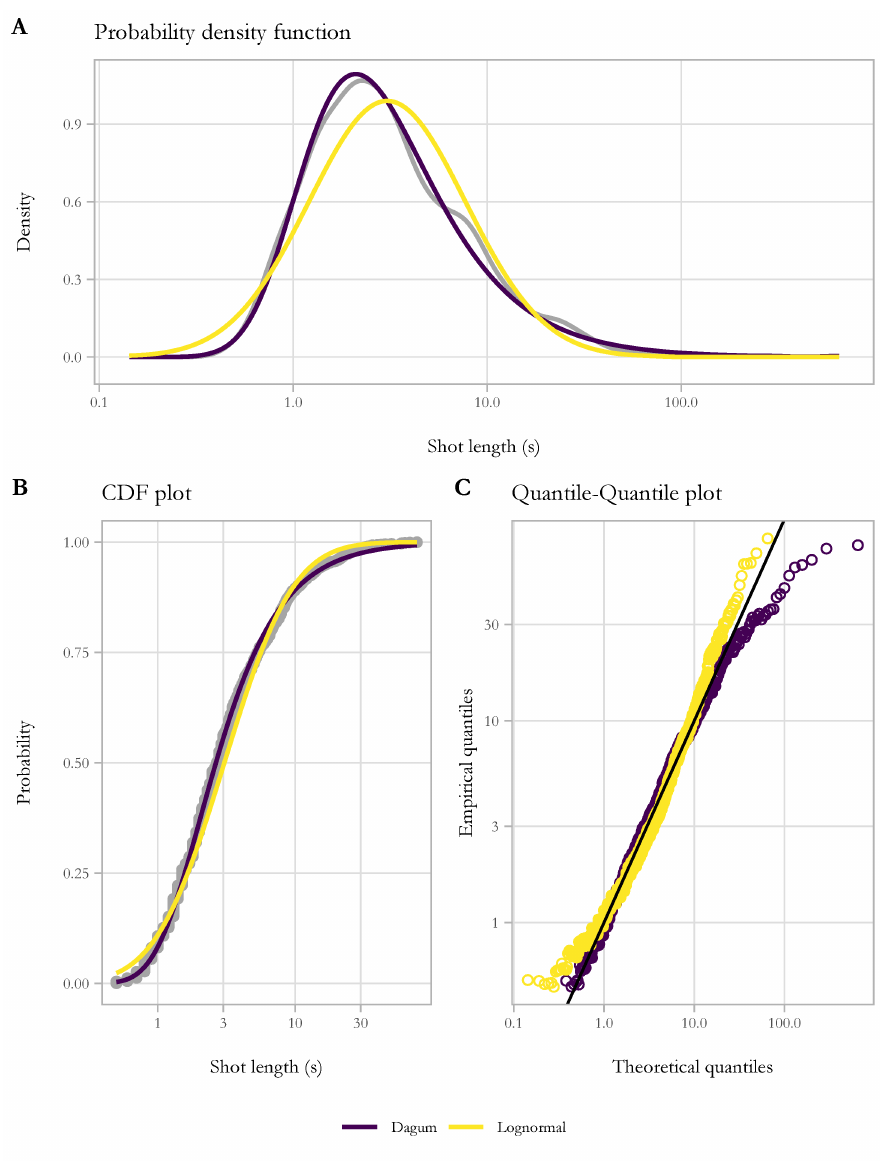
Figure 2 – Probability density function (A), cumulative distribution function (B) and quantile- quantile (C) plots for fitted three-parameter Dagum and two-parameter lognormal distributions for Back to the Future